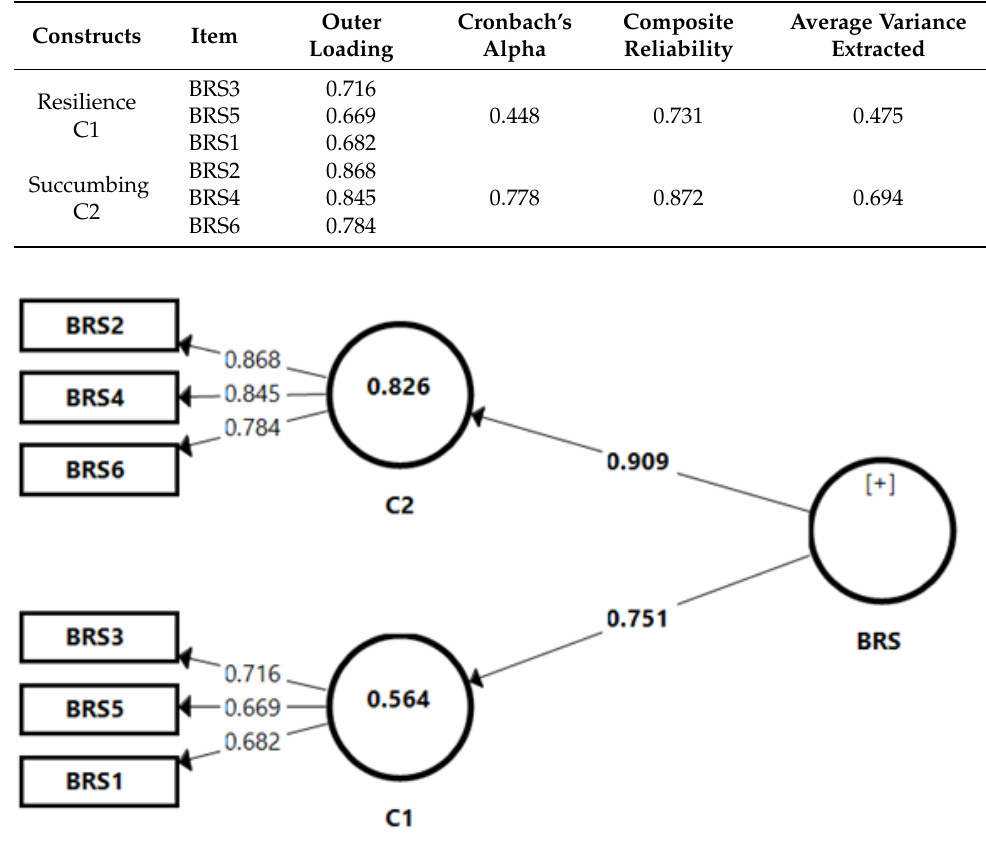
Figure 1. Output of Pratt’s Importance Measure Matrix Model.